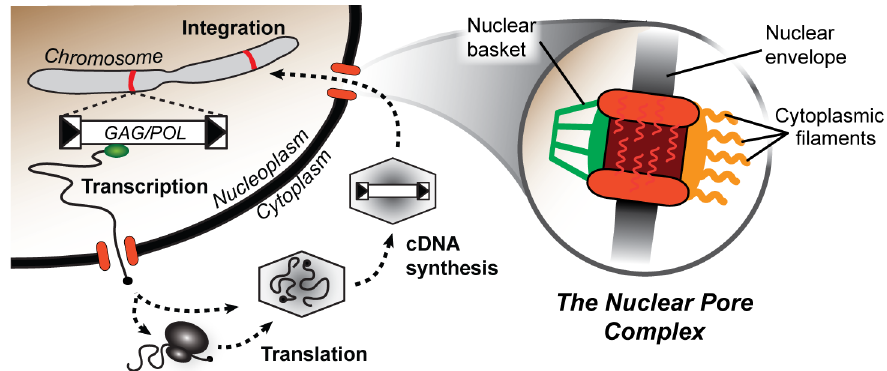
Fig 1. The nuclear pore complex is important for Ty retrotransposition. Left . A generic schematic of the lifecycle of a Ty. Chromosomal copies of Ty, found in the yeast genome, produce full-length RNA transcripts that are exported from the nucleus. These transcripts are translated and also packaged within virus-like particles within the cytoplasm. Packaged RNAs are reverse transcribed into cDNA that is transported into the nucleus via the nuclear pore complex. The Ty integrase mediates insertion of the cDNA into the host genome at a new location (red stripes on the chromosome). Right . Simplified representation of the nuclear pore complex embedded in the nuclear envelope and sliced along its vertical axis. Filaments rich in phenylalanine and glycine (FG) radiate into the nucleoplasm, cytoplasm, and within the nuclear pore itself.